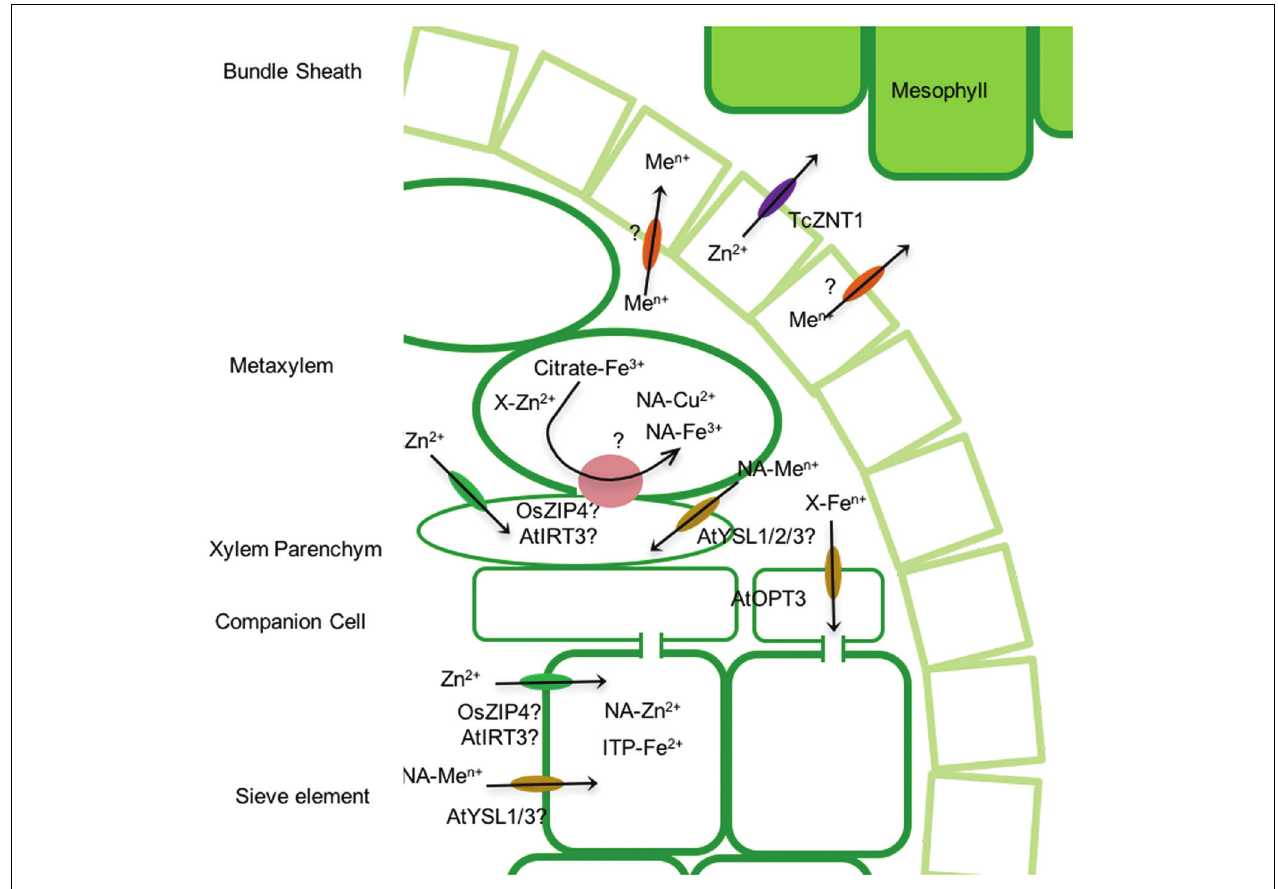
FIGURE 3 | Metal delivery to the mesophyll cells. At is used as a prefix to indicate A. thaliana proteins, Os for Oryza sativa , and Tc for Thlaspi caerulescens . X is used to indicate an unknown metal chelator. Me n + stands for a general metal.